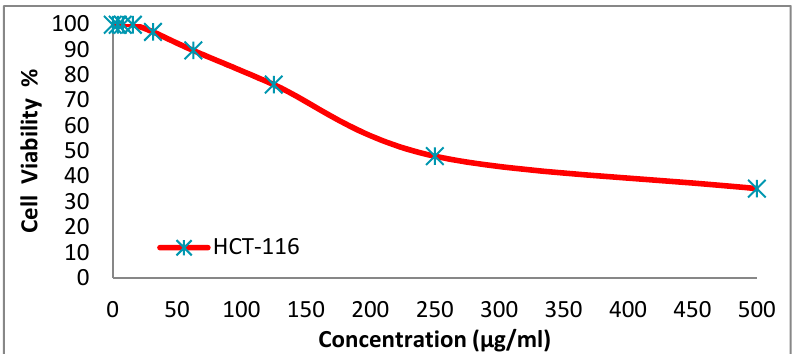
Figure 9. Evaluation of disperse dye 14y on cell line HCT-116.